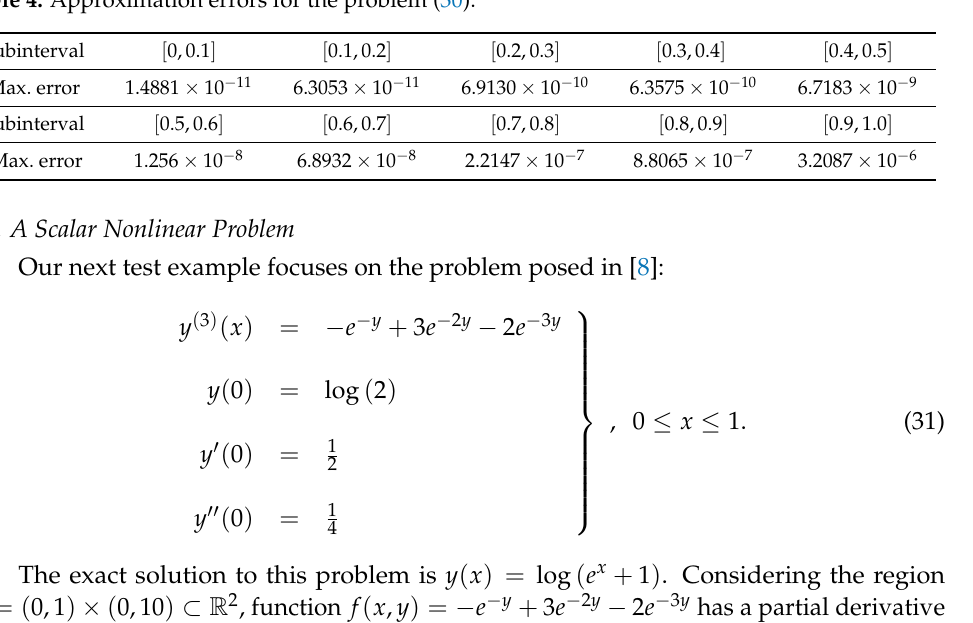
Table 4. Approximation errors for the problem (30).